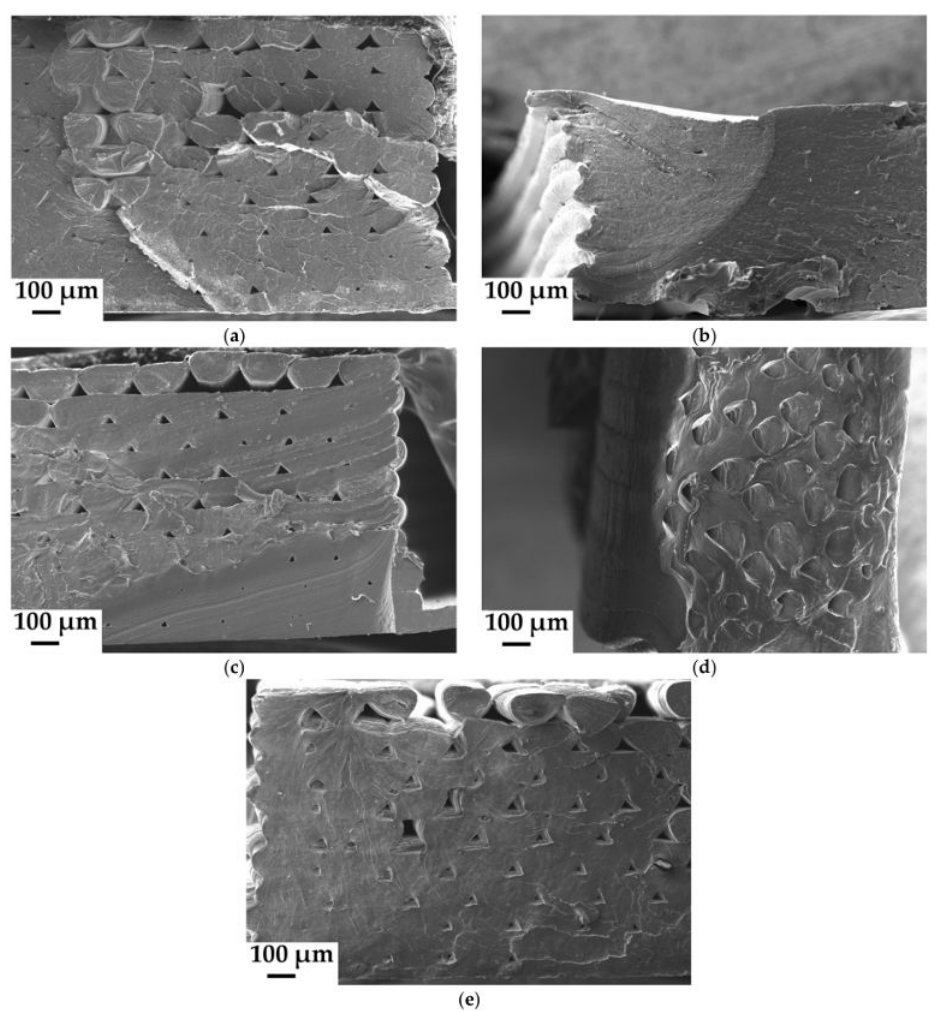
Figure 10. Scanning Electron Microscopy (SEM) micrographs of 3D printed dogbones fractured during tensile tests and made of: ( a ) PHB/PLA (reference); ( b ) PHB/PLA/C-4; ( c ) PHB/PLA/A-4; ( d ) PHB/PLA/A-6; and, ( e )